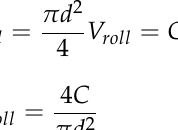
Figure 3. ( a ) Relative wire packing density along TD wr and ( b ) comparison of wire packing density as a function of ring pitch during Stelmor cooling.